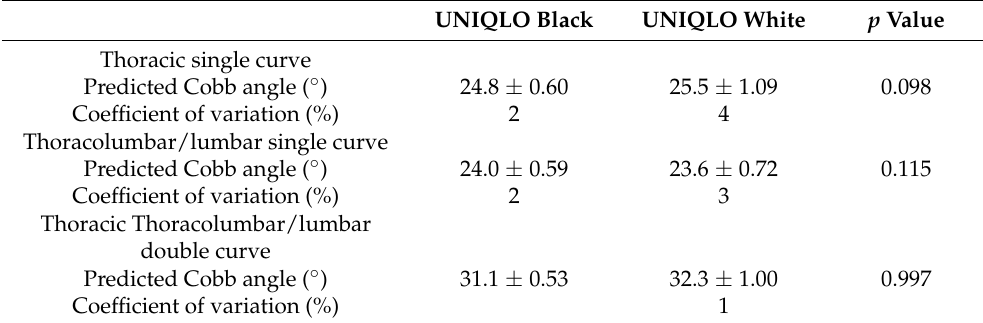
Table 2. Predicted Cobb angle and coefficient of variation in two color underwear types.